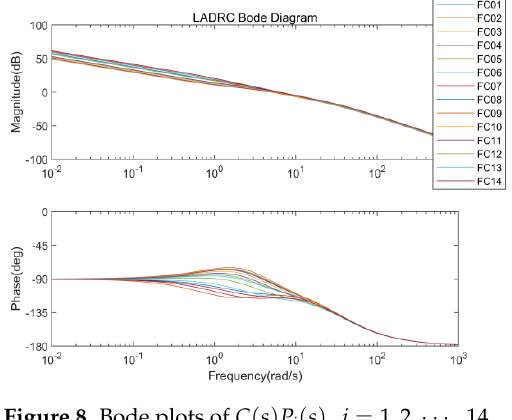
Figure 8. Bode plots of C ( s ) P i ( s ) , i = 1,2, · · · ,14.